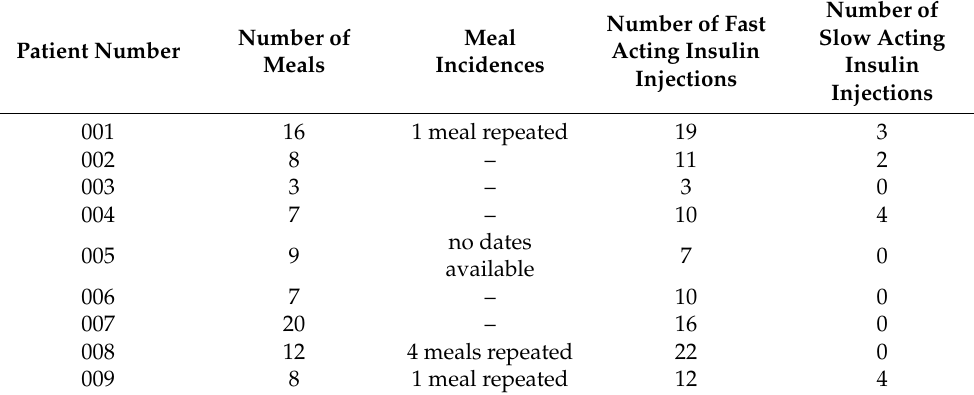
Table 1. Information about T1DM patients in the D1NAMO dataset.